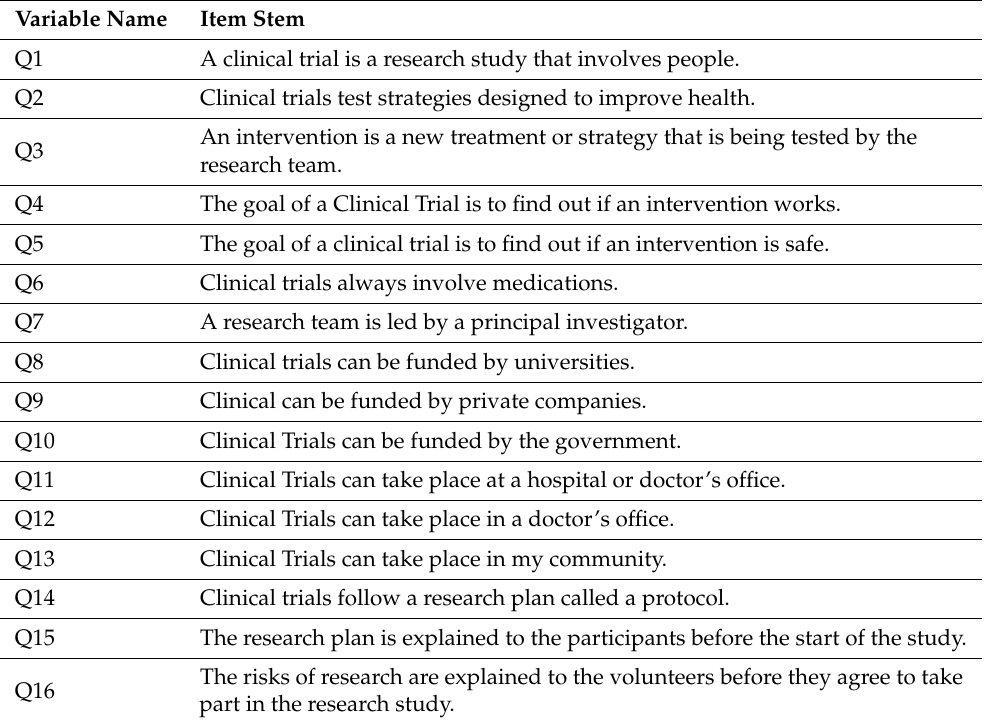
Table A1. The full 31-items in the Clinical Trial HEalth Knowledge and belief Scale (CHEKS) that we began with during survey